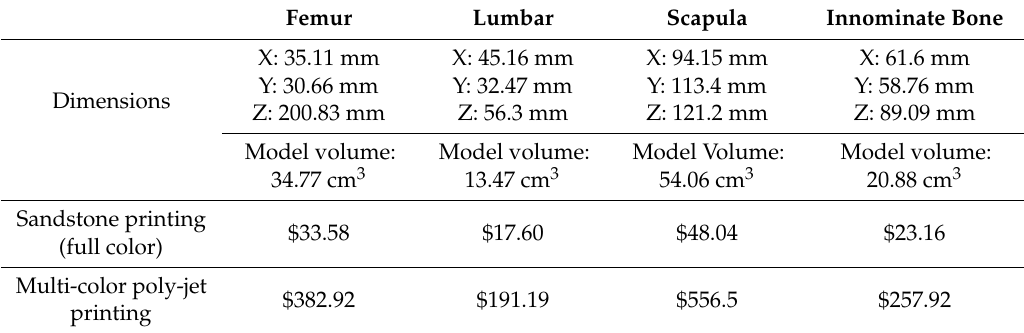
Table A1. Dimensions and pricing comparisons between full-color sandstone and full-color multi-color poly-jet printing through